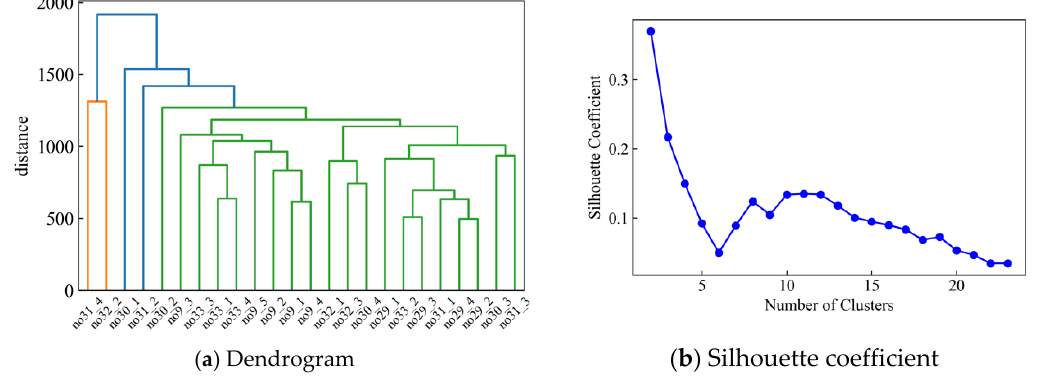
Figure 5. Clustering result of 24 standing behavior from chair, sofa, and nursing